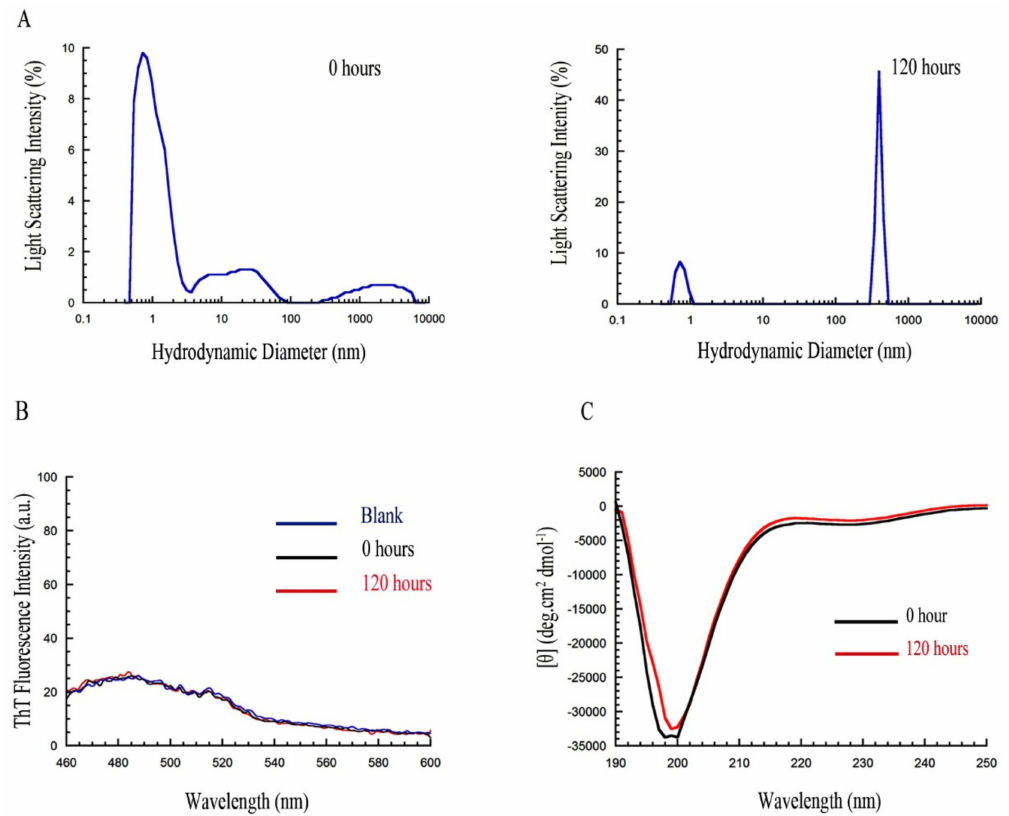
Figure 2. E ff ect of 20 mM phosphate bu ff er, 200 mM Na 2 SO 4 , pH 7.0, 37 ◦ C on PrP 107–120 (1.0 mg / mL) aggregation. ( A ) Size distributions by light scattering intensity of the peptide sample obtained with DLS at t = 0 h (left) and 120 h (right) under the conditions described above. ( B ) Thioflavin T (ThT) fluorescence spectra with bu ff er (blank) and PrP 107–120 sample after 0 and 120 h. Peptide sample was incubated as described above. ThT assay was carried out at 22 µ M ThT, 0.12 mg / mL PrP 107–120 (final concentrations in the cuvette), pH 6.0, 37 ◦ C. ( C ) Far-UV circular dichroism (CD) spectra of PrP 107–120 incubated for 0 and 120 h. Peptide sample was incubated as described above and diluted to 0.2 mg / mL in the same bu ff er before spectrum acquisition at 25 ◦